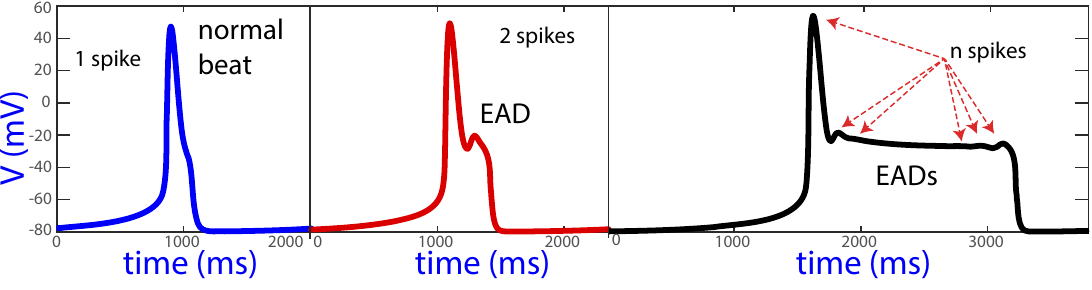
Figure 1. Normal beat and beats with one or more